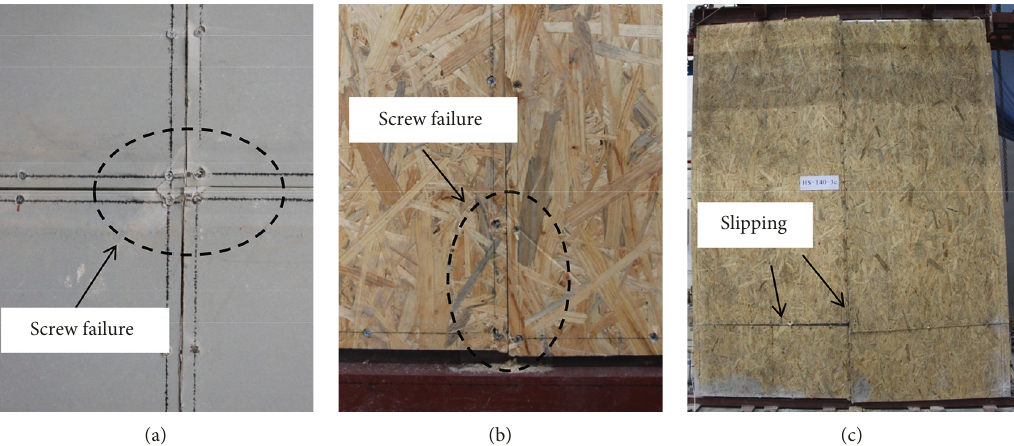
Figure 4: Typical failure modes of CFS shear walls: (a) failure in gypsum-CFS connections, (b) failure in OSB-CFS connections, and (c) relative slips at board seams.